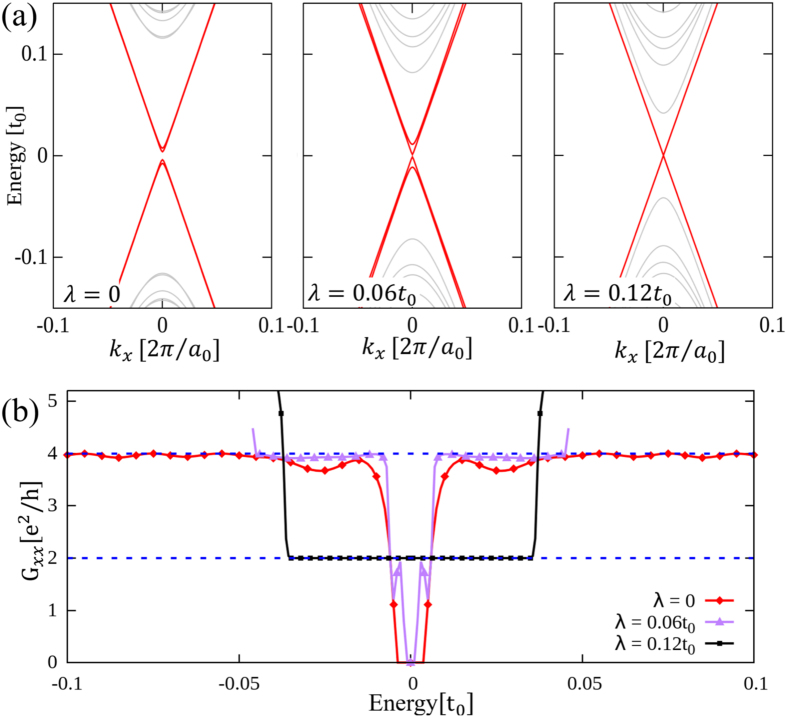
Edge states and conductances of the topological phase in the presence of SOC.(a) Dispersion relations and (b) longitudinal conductances of the topological system same as that given in Fig. 4(a) except that finite SOC is included.